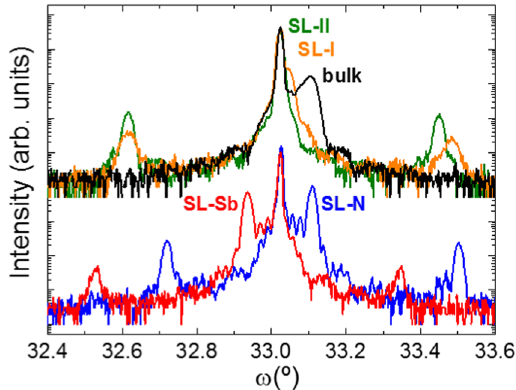
Figure 2. High resolution X-ray diffraction of the different structures. Omega-2 theta scans around the (004) GaAs Bragg reflection performed on the ternary samples SL-Sb and SL-N (below) and on the samples SL-I, SL-II , and bulk (above). The most intense peak at 33.0239° corresponds to GaAs. The main peak of the two ternary SLs are perfectly symmetric with respect to that of GaAs, indicating an equivalent compressive ( SL-Sb ) and tensile ( SL-N ) accumulated strain. Only the GaAsSb/GaAsN structure ( SL-II ) satisfies perfectly the lattice matching condition (main peak coincident with that of GaAs) expected from the combination of both ternaries.